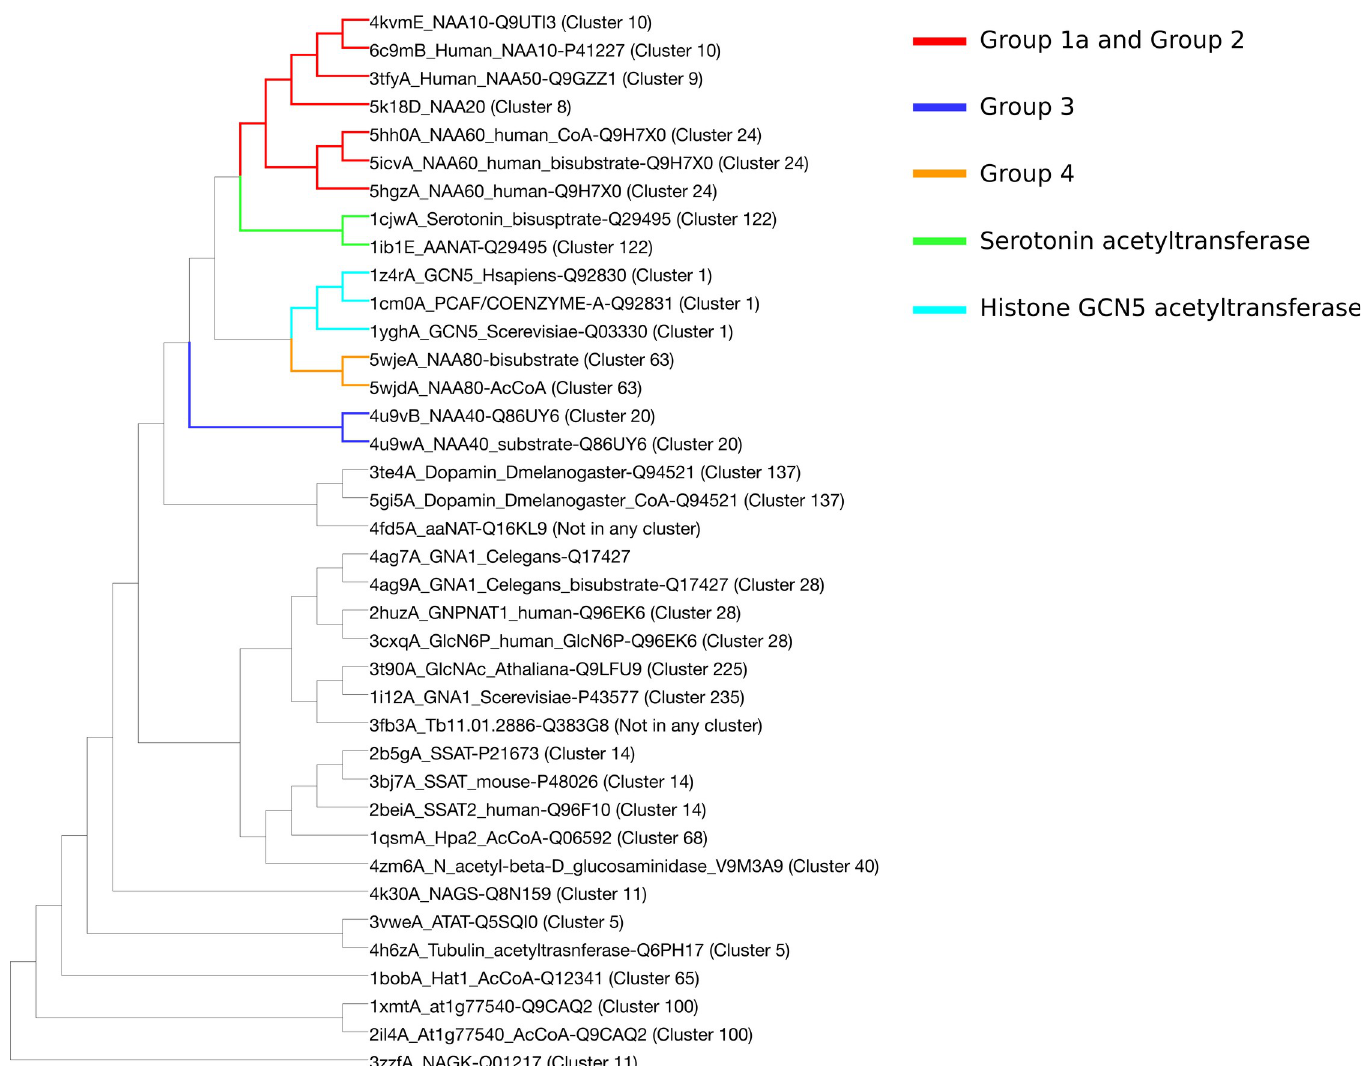
Fig 4. DALI dendrogram for structural similarity between acetyltransferases. The dendrogram is the result of hierarchical clustering of structures. The known NATs are closer to one another than to the rest of the superfamily. Note the non-NAT acetyltransferases located close to known